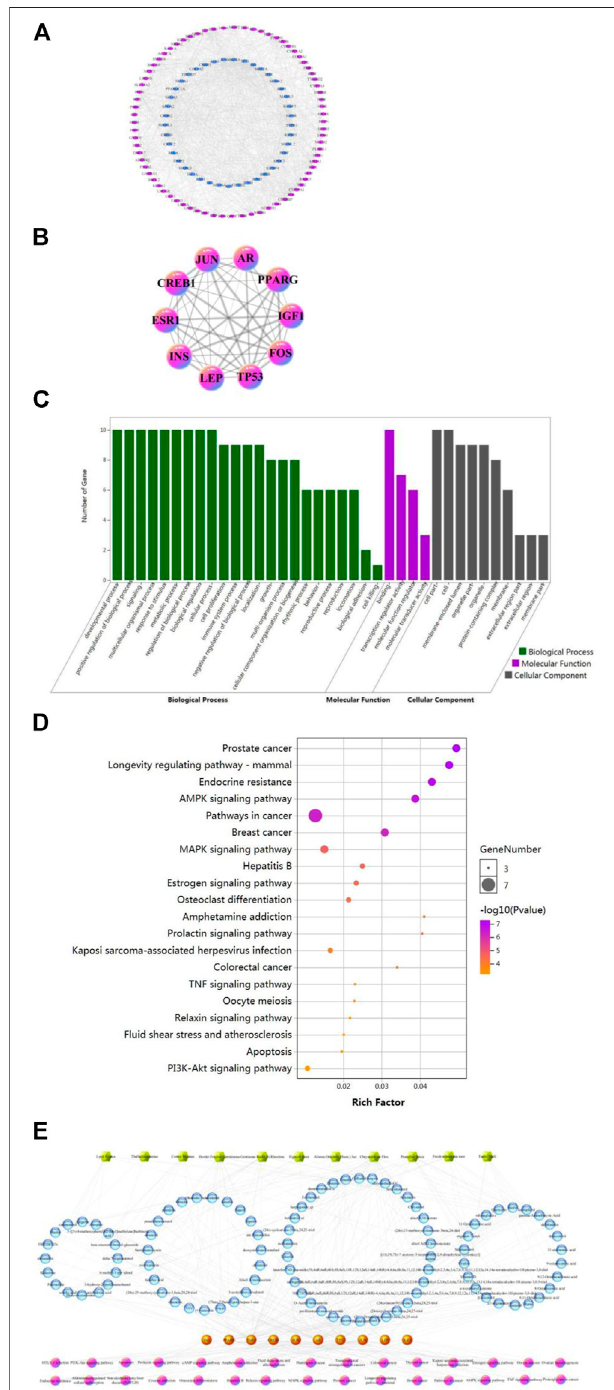
FIGURE 1 | Compound-target interaction network and preliminary gene ontology (GO) analysis of drug targets. (A) Compound-key target network of the FY. (B) Compound-hub target network of the FY. (C) GO analysis of drug targets classi fi ed into three categories: biological process, molecular function, and cellular component. (D) Kyoto Encyclopedia of Genes and Genomes (KEGG) pathway analysis of core targets of the FY in the treatment of PP. (E) Chinese medicinal materials-core component-key target-main pathways.